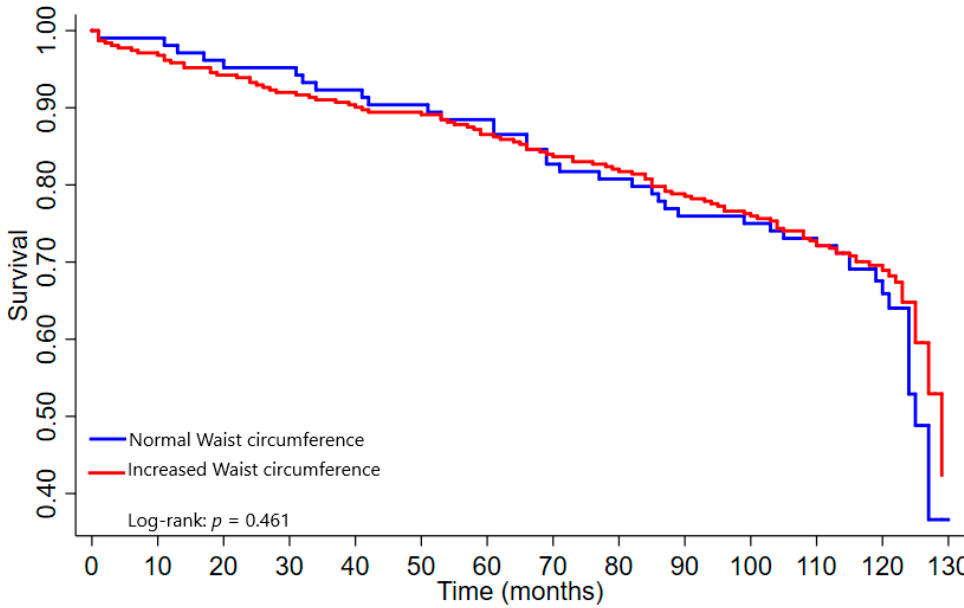
Figure 2. Survival curve according to waist circumference (WHO, 1995) [38]. Note: Increased waist circumference: ≥ 88 cm in women and ≥ 102 cm in men.